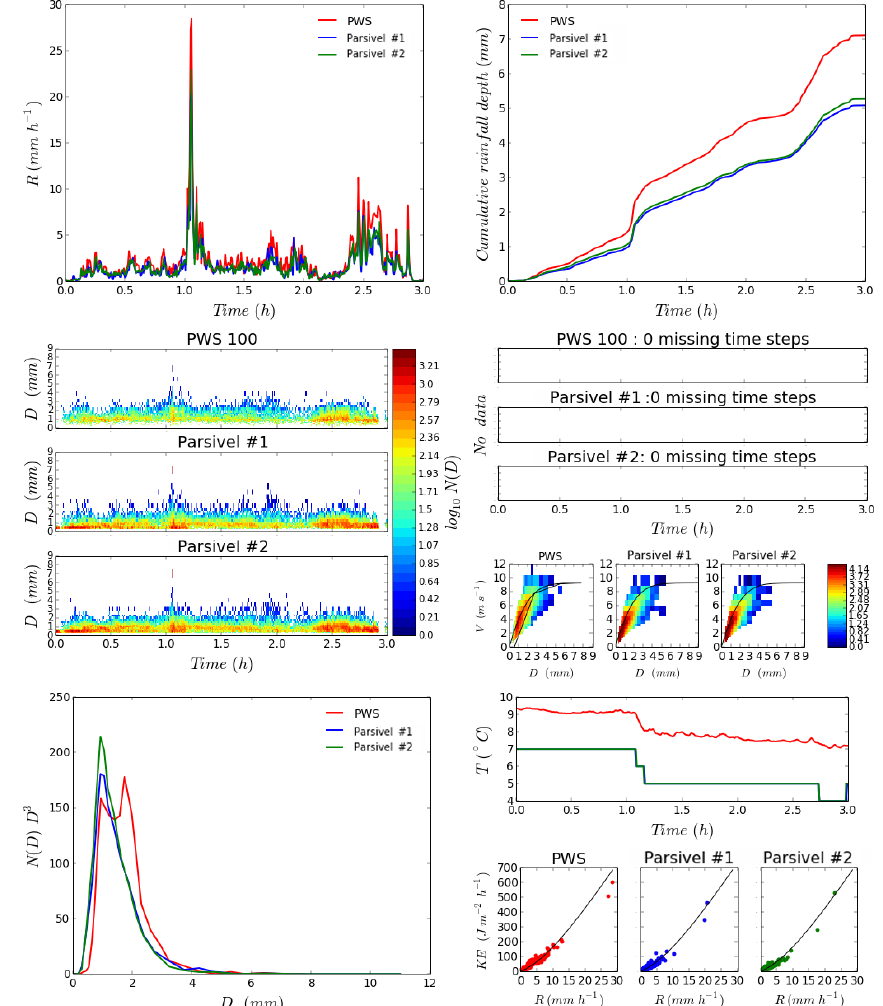
Figure 7. Quicklook of the measurements carried out on the roof of the Carnot Building of ENPC campus on 10 February 2019 between 07:00:00 and